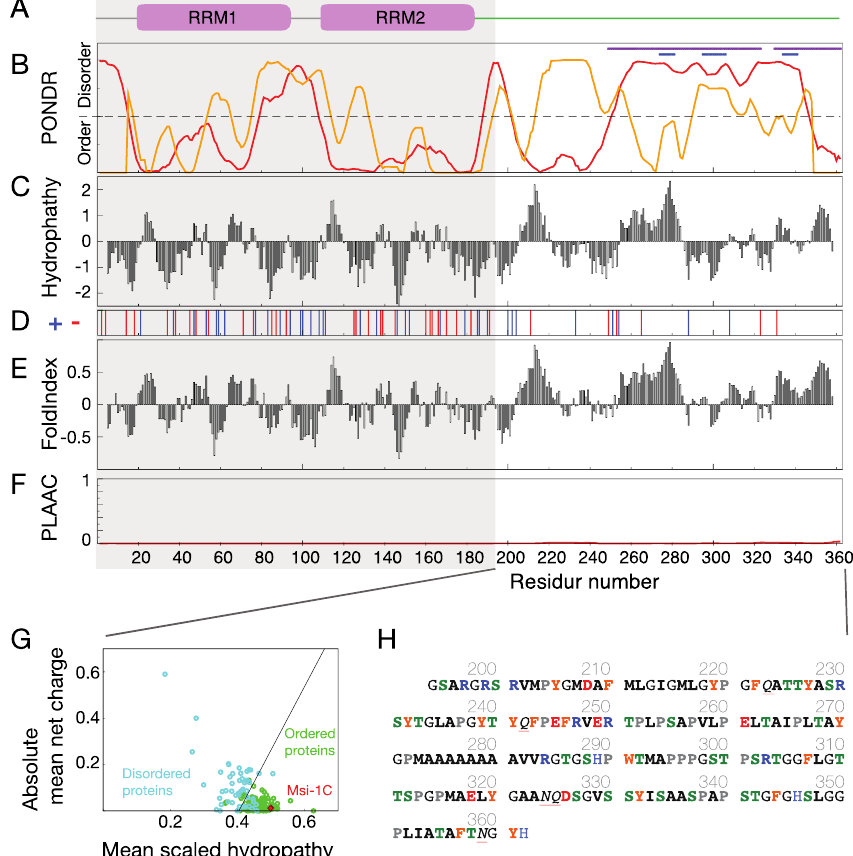
Figure 1. Primary sequence analysis of Musashi-1. ( A ) Functional domains predicted by PROSITE [32] and deposited structures. ( B ) Levels of protein disorder predicted by the PONDR VLXT (red) and XL1_XT (yellow) algorithms [37]. The two regions with low sequence complexity predicted using the SEG algorithm [35] are shown with blue and purple bars. ( C ) Hydropathy according to the Kyte and Doolitte scale (average window size: 9). The scale of each amino acid is derived from experimental observations from solved structures [38]. ( D ) Positions of positively (blue) and negatively (red) charged residues. ( E ) FoldIndex folding [36]. ( F ) Prion-likeness predicted by the PLAAC algorithm [39]. ( G ) Charge–hydropathy plot for a database of known disordered proteins (blue) and folded proteins (green) and the residues 194–362 of Musashi-1 (red) [37]. ( H ) The primary sequence used in this study, with residues labeled according to their properties (blue: positive; red: negative; green: potential phosphorylation sites; orange: aromatic residues; gray: prolines; black: hydrophobic residues).